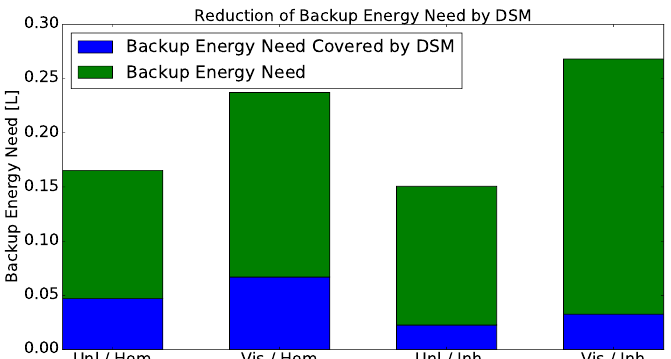
Figure 4. Need for backup energy and possible reduction by DSM. Entire bars show the need for backup energy without DSM. Blue components show the possible reduction by DSM. The backup energy need is measured in units of the overall consumption.